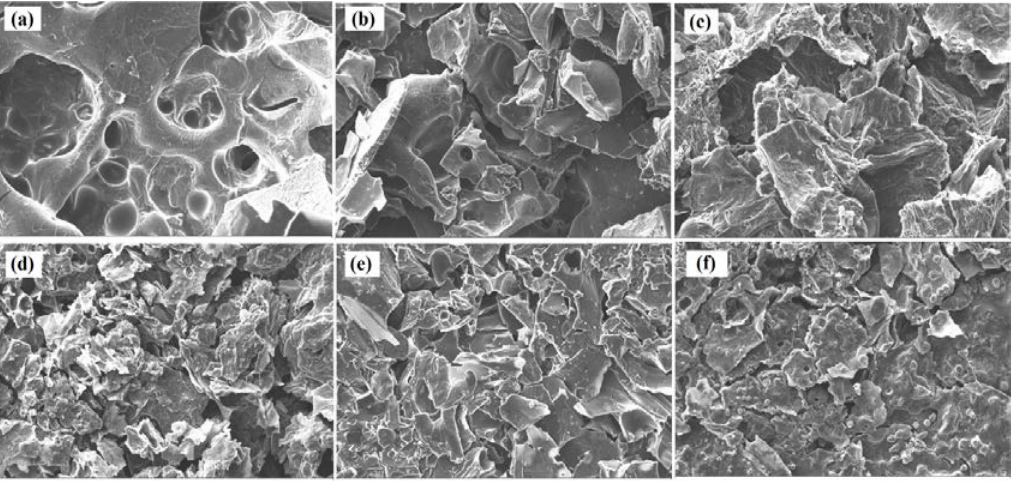
Figure 7. SEM analysis of the residues of PLA/APP10 ( a ), PLA/APP15 ( b ), PLA/APP20 ( c ), PLA/APP20/ST3 ( d ), PLA/APP20/ST5 ( e ), and PLA/APP20/ST7 ( f ) after cone calorimetry test. Scale bar in all panels = 10 μm, Magnification = 710×.